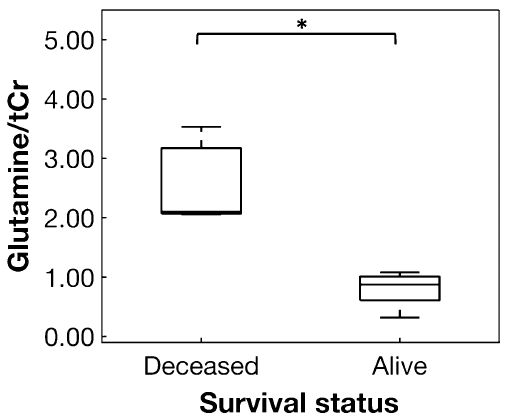
Figure 2. Glutamine concentration varied significantly as a function of survival status. Glutamine concentration was significantly higher in deceased versus alive patients when assessed with a Mann–Whitney U-test ( p = .012). Glutamine was normalized to creatine + phosphocreatine (tCr). *Denotes significance at p ≤